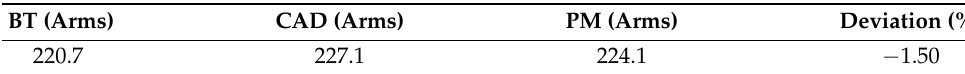
Table A2. Comparison results on a short-circuit